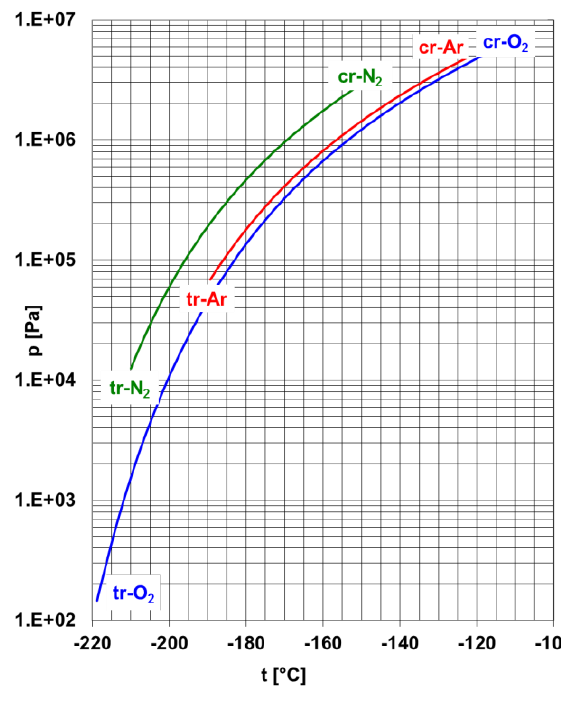
Fig. 1. Liquid-vapor saturation curve in the phase p t  diagram for the three most important components of dry air: nitrogen N - green, oxygen O - blue, argon A r - red; cr - 2 2 critical point, tr - triple point